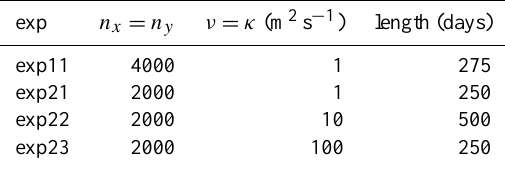
Table 2. Parameters varied between numerical